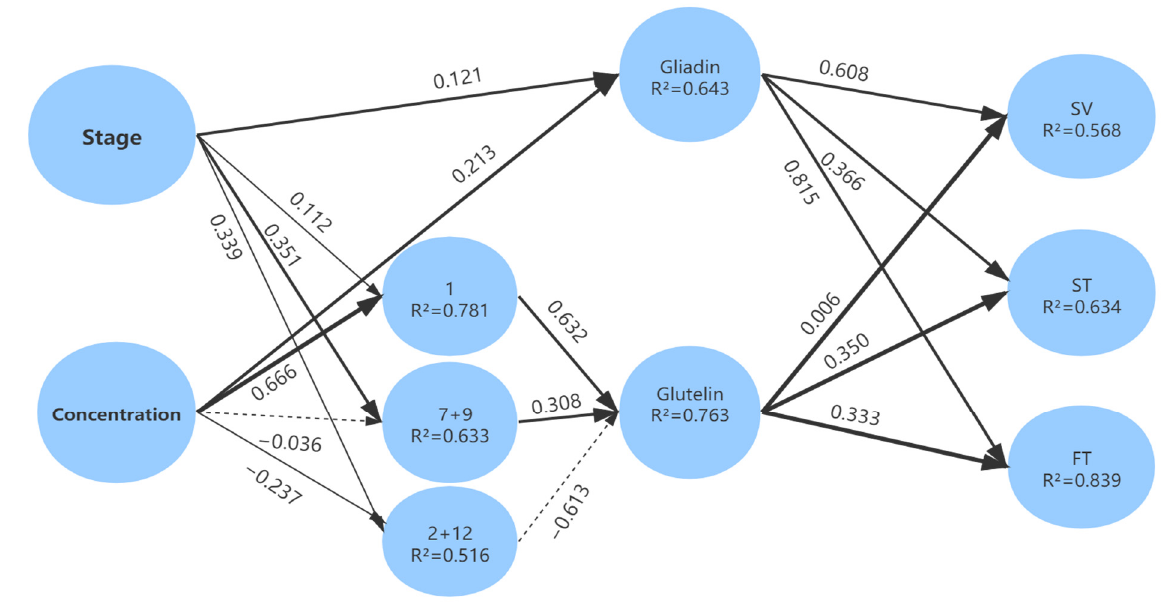
Figure 10. The results of PLS-PM showed the direct and indirect effects of stage and concentration of potash application, Gliadin, Glutelin, and HMW-GS (1, 7 + 9, 2 + 12) on the process quality index (sedimentation value (SV), stabilization time (ST), formation time (FT)) of wheat XY22. Solid and dotted arrows represent the positive and negative relationships, respectively. The strength of path coefficients is proportional to the width of arrows. The variance of the explained proportion is expressed in terms of R 2 .